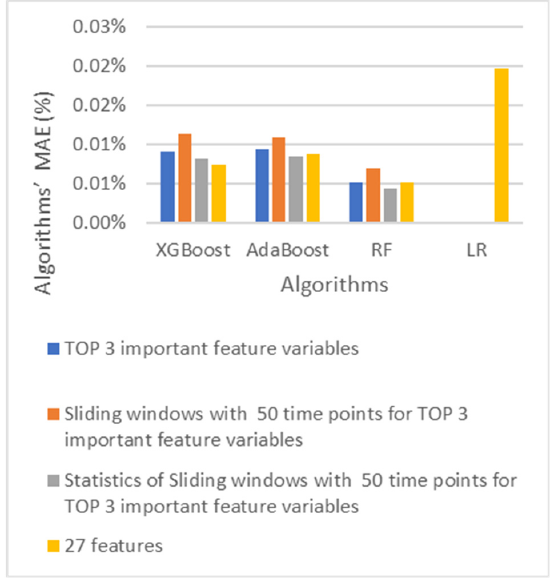
Figure 6. Comparison of algorithms’ MAE when selecting different input variables (accuracy